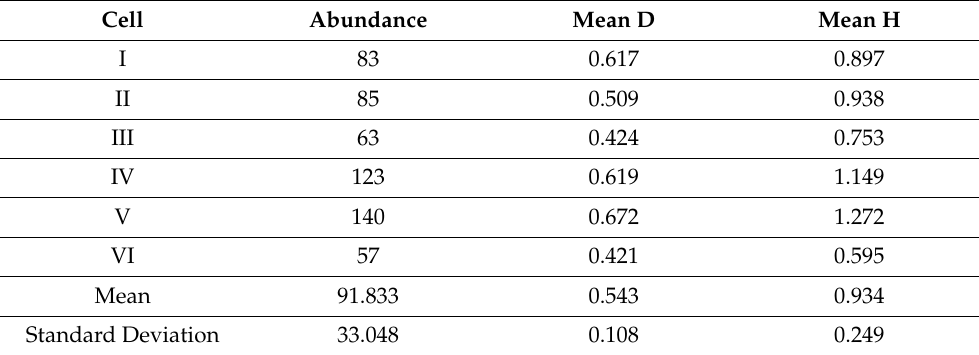
Table 4. Bee abundance and diversity (D = Simpson Index and H = Shannon Index) in the selected grid